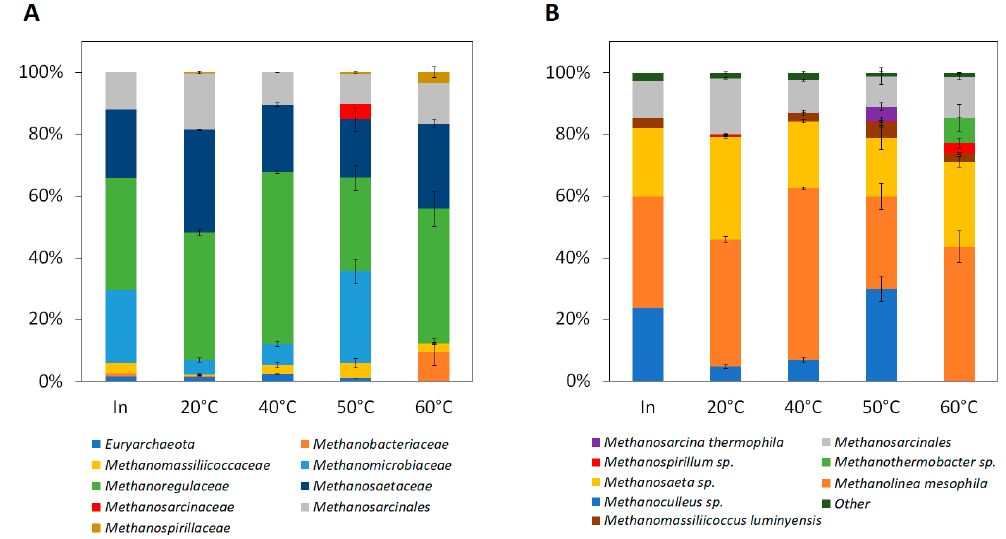
Figure 5. Methanogenic archaeal community composition at different temperatures. Taxonomic profiles at the ( A ) family level and ( B ) species level. Inoculum sampled first day, other samples 18th day. Data from fermenters are presented as means from three independent cultivations.